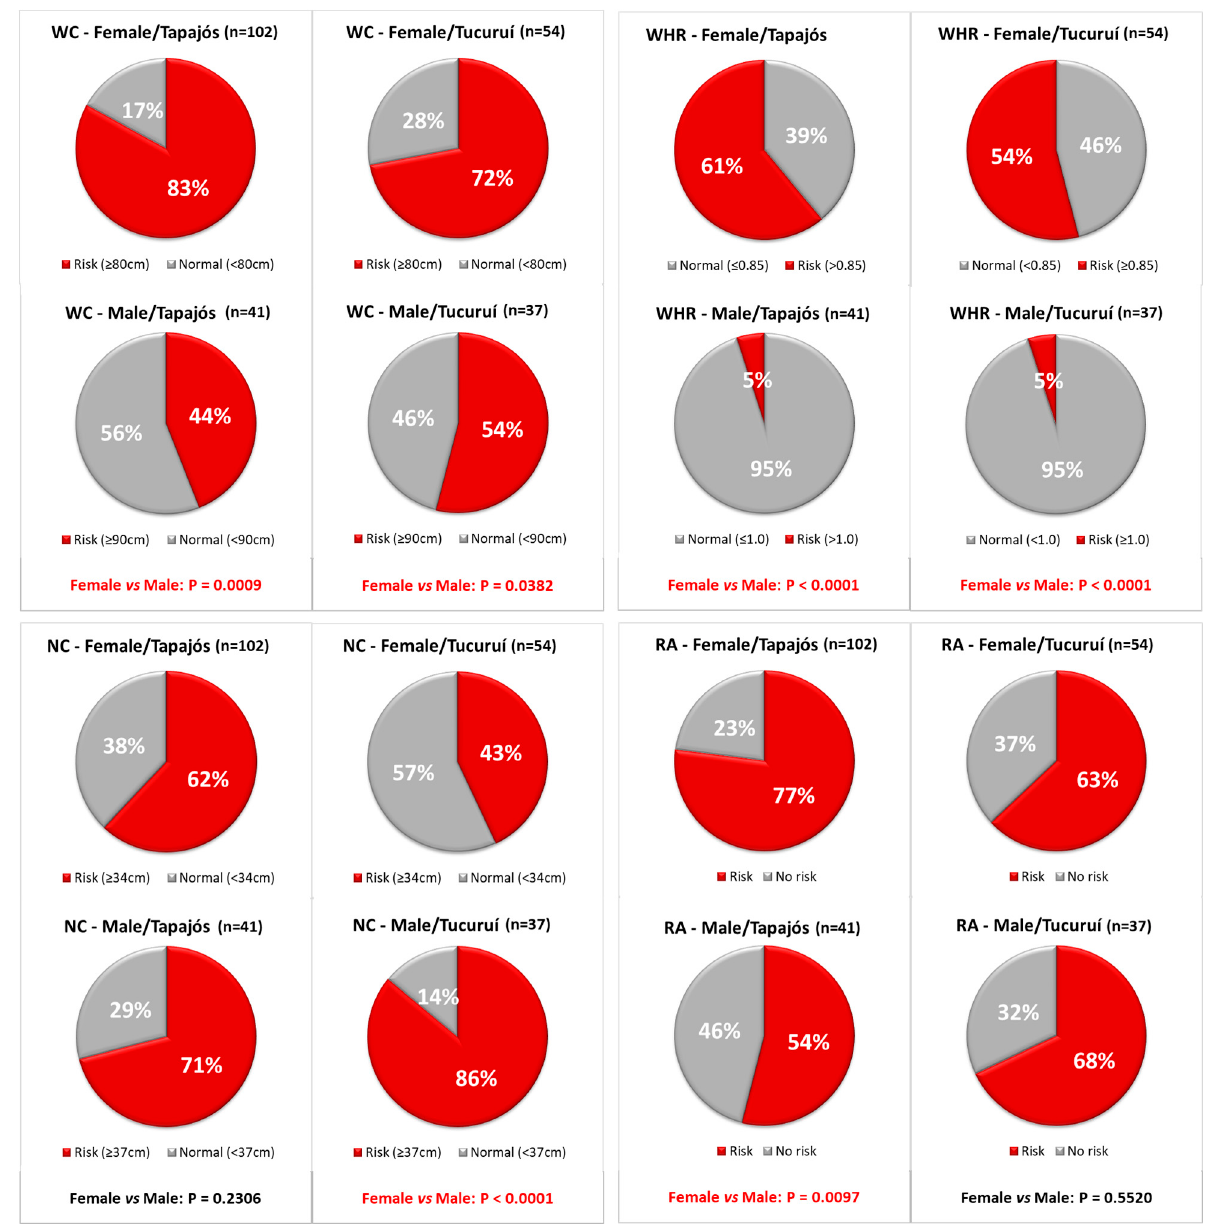
Figure 3. The prevalence of individuals at risk of cardio-metabolic impairment associated with obesity, according to the waist circumference (WC, above left), waist-to-hip ratio (WHR, above right), neck circumference (NC, below left), and risk analysis (RA, below right). Differences between genders (female vs. male) were evaluated by Fisher’s test for each region and highlighted in red when they were significant.